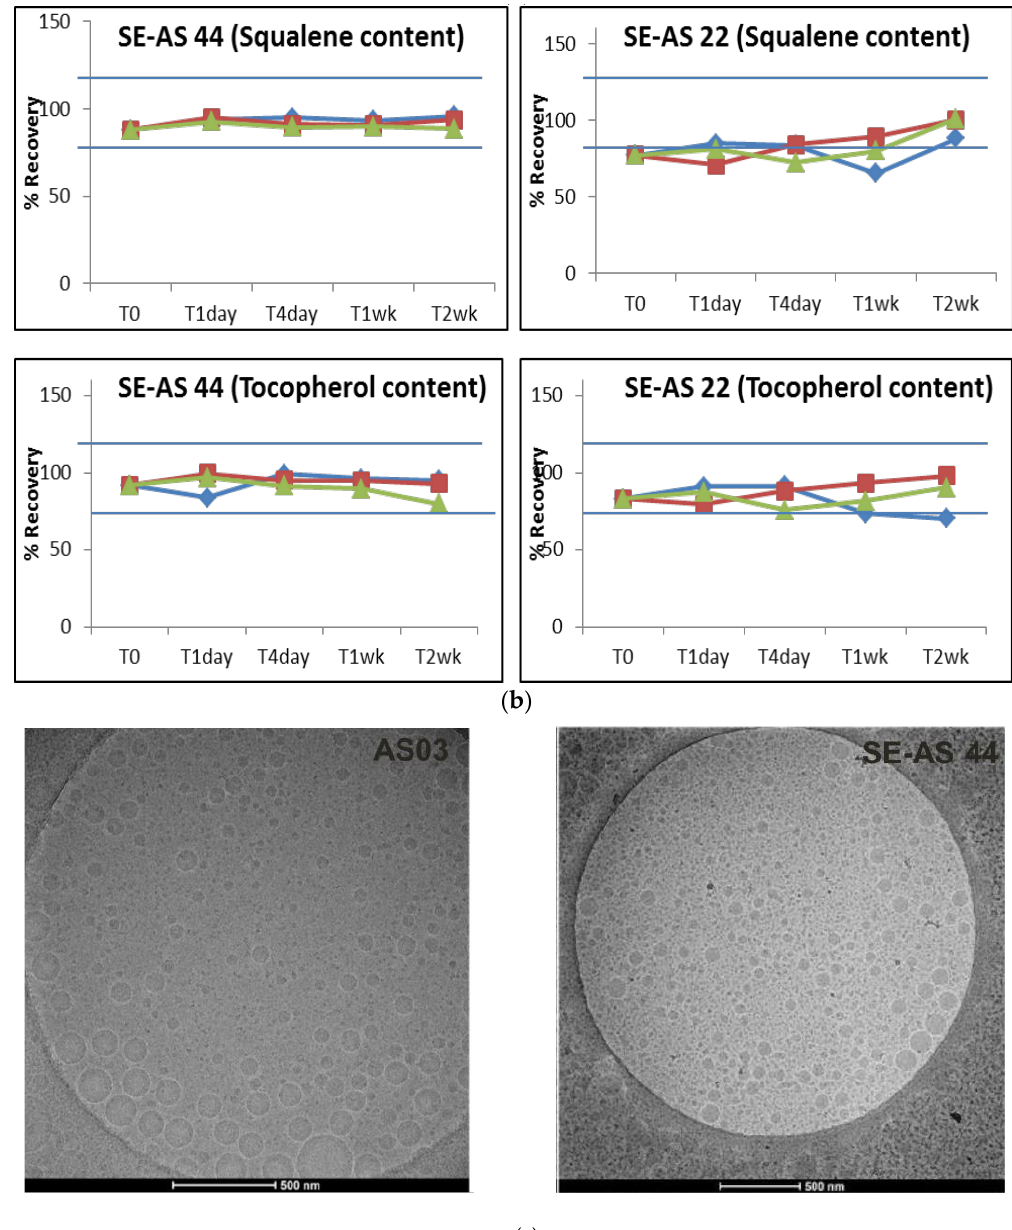
Figure 1. ( a ) Size and PdI for emulsions up to 10 weeks stored at 4 °C (blue), 25 °C (red) and 50 °C (green). ( b ) % Squalene and Tocopherol content for emulsions stored at 4 °C (blue), 25 °C (red) and 50 °C (green) for up to 2 weeks. The blue lines represent the acceptable limits of % content, i.e., 100% ± 20%. ( c ) Cryo-EM images of AS03 and SE-AS44 showing comparable droplet morphology. The oil droplets in AS03 are slightly bigger than SE-AS44, as expected.